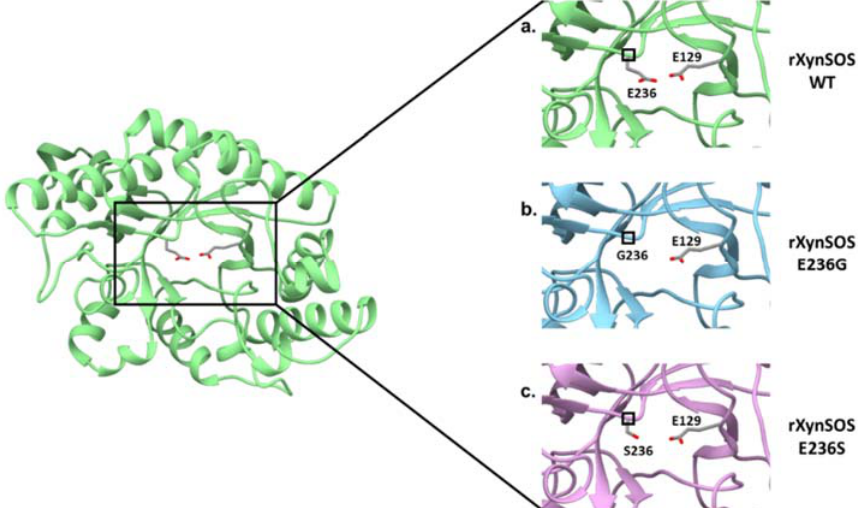
Figure 3. Conversion of T. amestolkiae rXynSOS into the glycosynthase variants rXynSOS ‐ E236G and rXynSOSE236S. The three ‐ dimensional model of the rXynSOS GH10 domain was obtained with SWISS ‐ MODEL. The server selected as a template the PDB structure 6Q8M (GH10 endoxylanase from Aspergillus aculeatus ), which has a sequence identity of 65.35% and resulted in a model of QMEAN 0.86. The catalytic amino acids E236 and E129 are displayed ( a ). Substitutions of the nucleophile catalytic residue E236 for G236 (lacking the side chain, b ) and for S236 (shorter side chain, c ) are shown to illustrate their effect in eliminating or reducing the hydrolytic capacity of the enzyme.